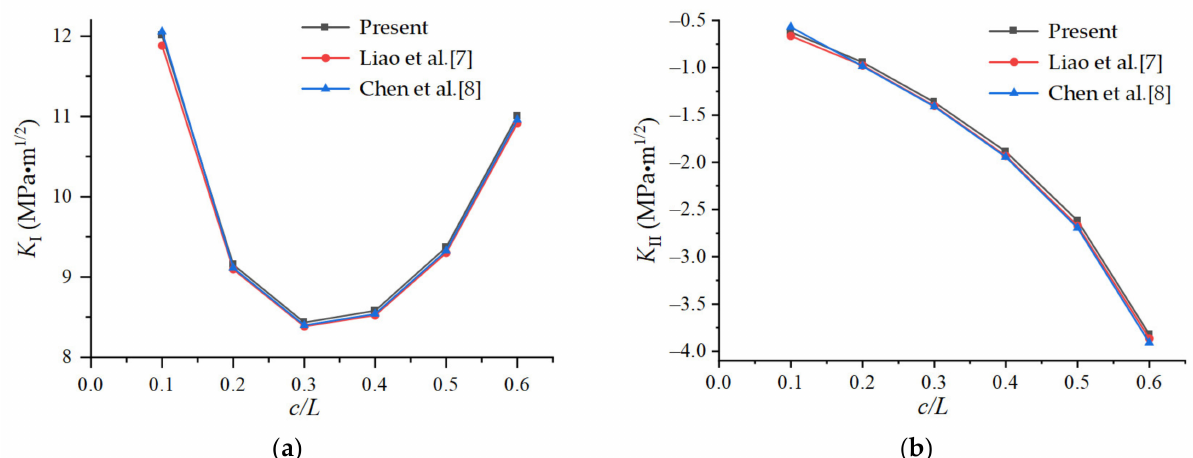
Figure 6. SIFs for different crack spacings ( L/W = 1): ( a ) SIFs K I ; ( b ) SIFs K II .